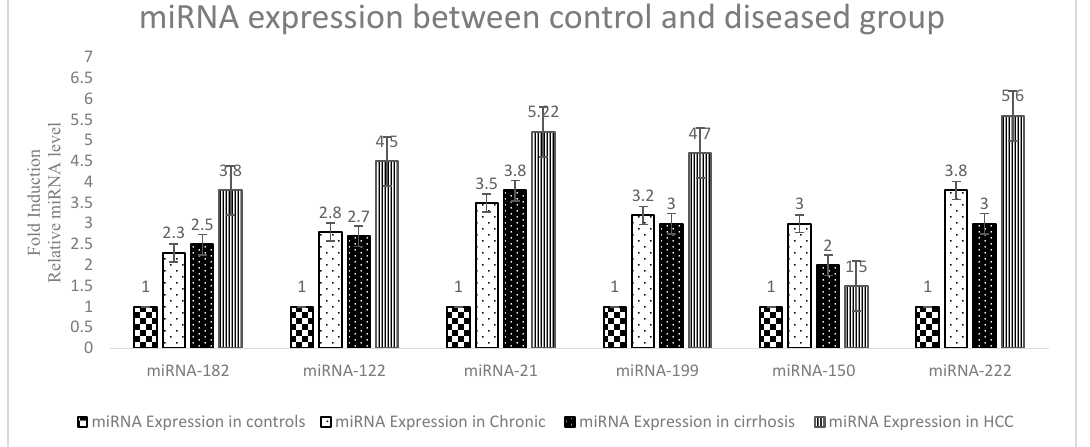
Figure 3. Graphical representation of the comparison of viral load among the chronic and treated groups. 3.5. Expression Analysis of miRNAs in Diseased and Control groups using Real-Time PCR